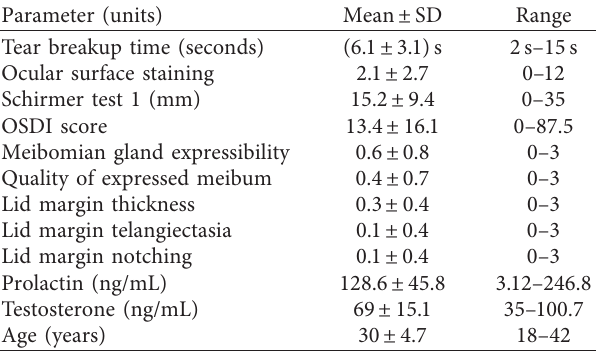
Table 1: Group mean measurements for serum hormones, dry eye symptoms, and ocular surface